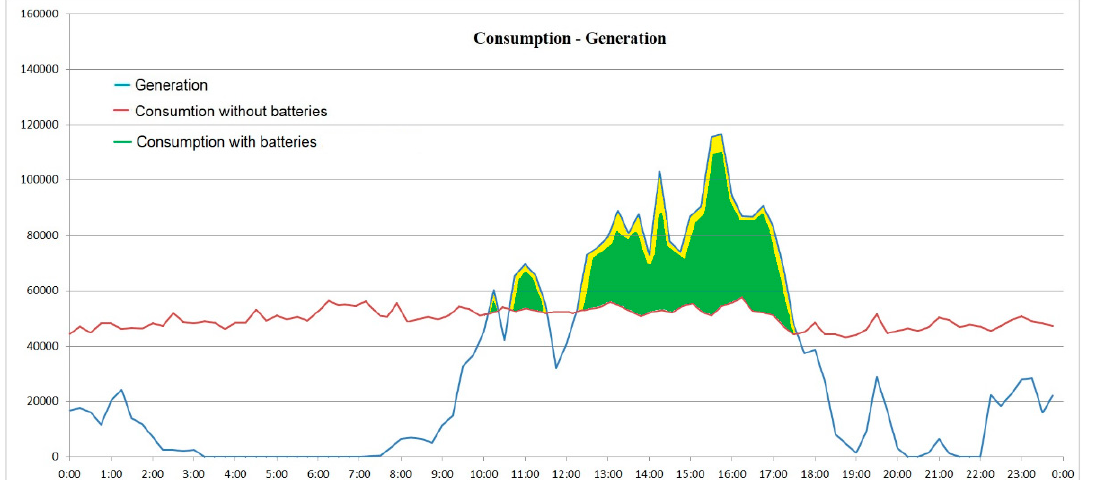
Figure 12. Daily microgrid generation–consumption after implementation. Source: prepared by authors based on the results of this study.